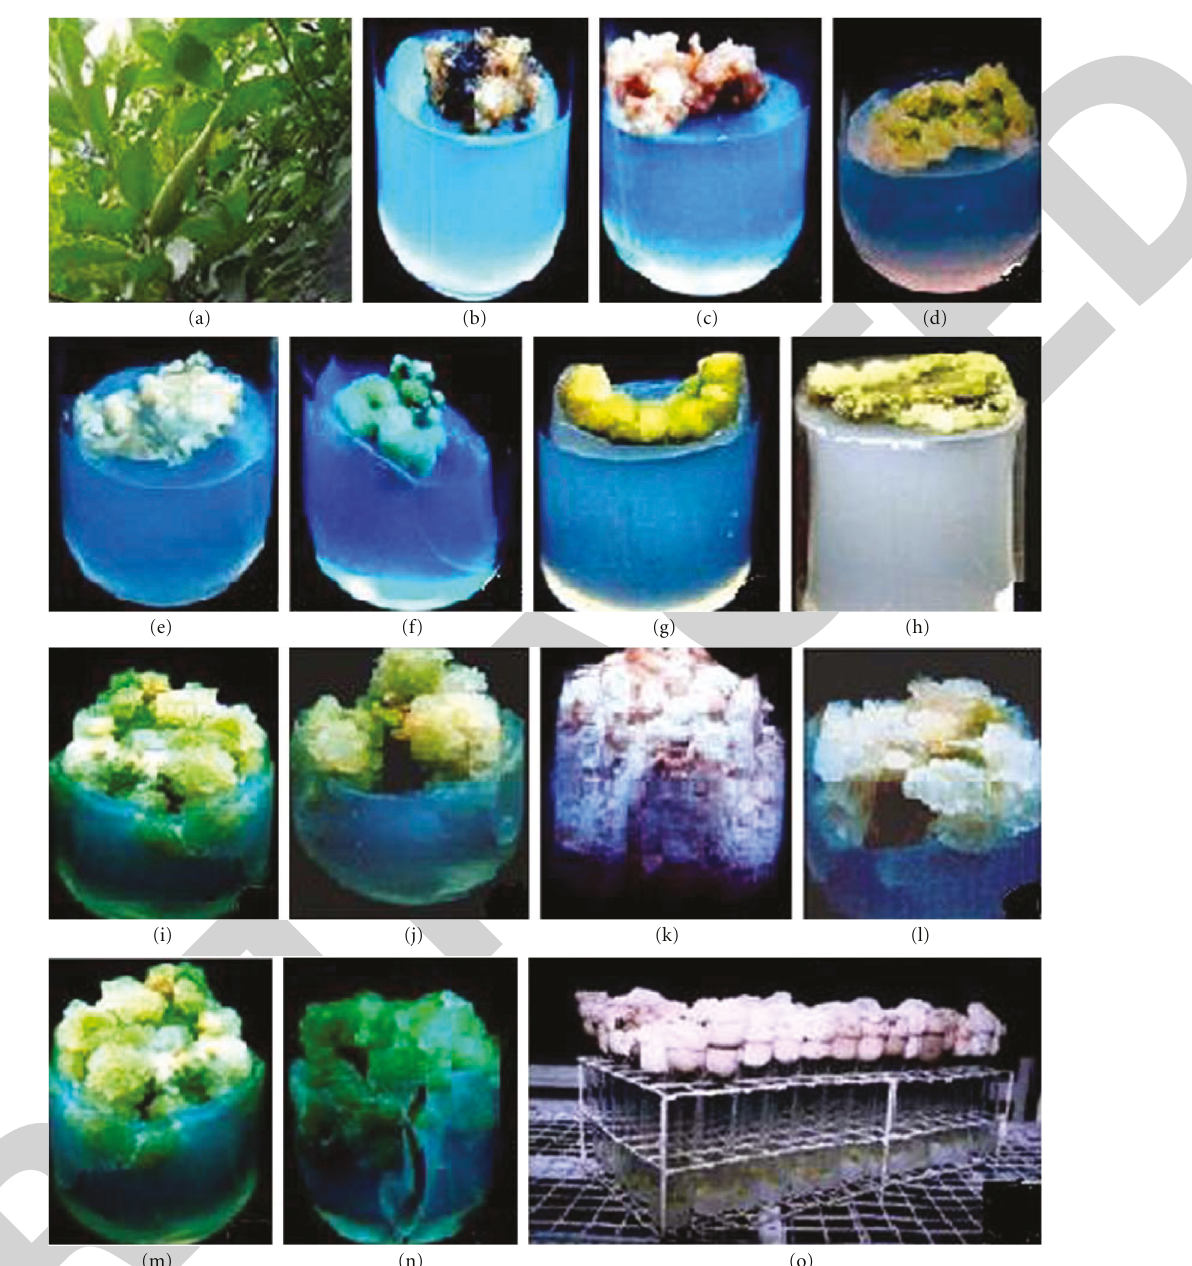
Figure 1: E ff ect of culture media, explants, and PGRs on callus induction in Gymnema sylvestre after 45 days. (a) Habit; (b) B5 medium (1.2x); (c) SH medium (1.3x); (d) MS medium (1.3x); (e) WPM medium (1.4x); (f) petiole (1.2x); (g) stem (1.3x); (h) leaf explants